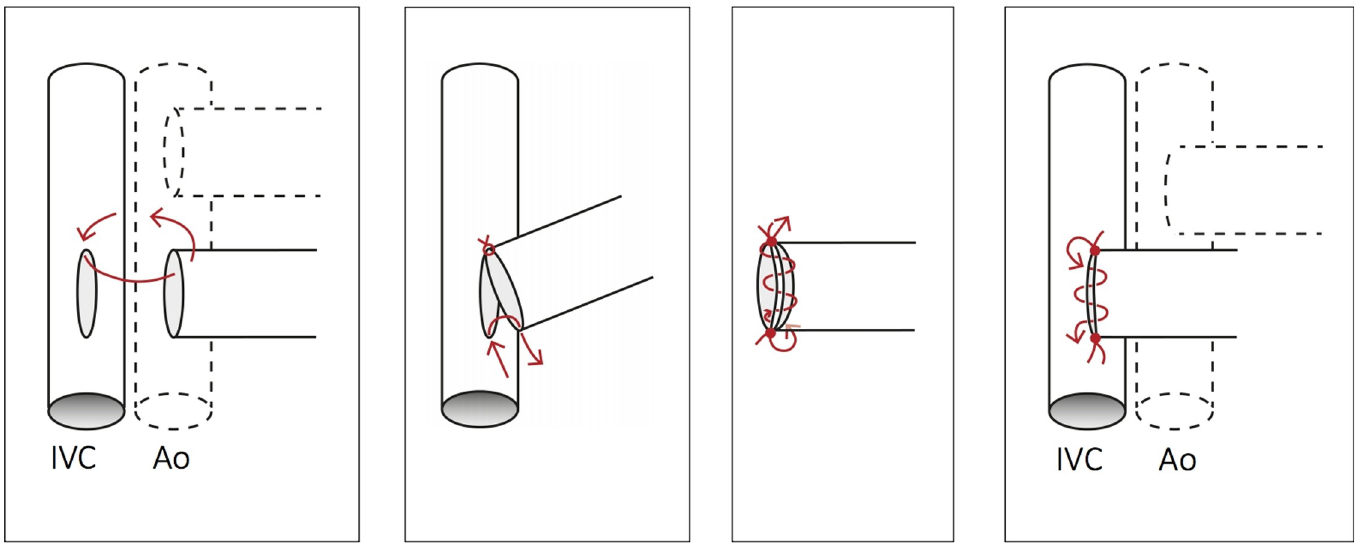
Fig 6. a-d: Schematic illustration of the venous anastomosis on the inferior vena cava (IVC), while the broken line indicates the abdominal aorta (Ao). For the venous anastomosis, also proximal and distal anchor stiches were performed (Fig 6A and 6B). Fig 6C shows how after the distal anchor stitch was performed, the suture was pulled through outwardly between the pulmonary artery and the inferior vena cava (IVC), so the continuous suture could then be started on the right side of the anastomosis, stitching from outside-to-inside and inside-to-outside (5–7 stiches). Fig 6D shows the left side of the anastomosis.